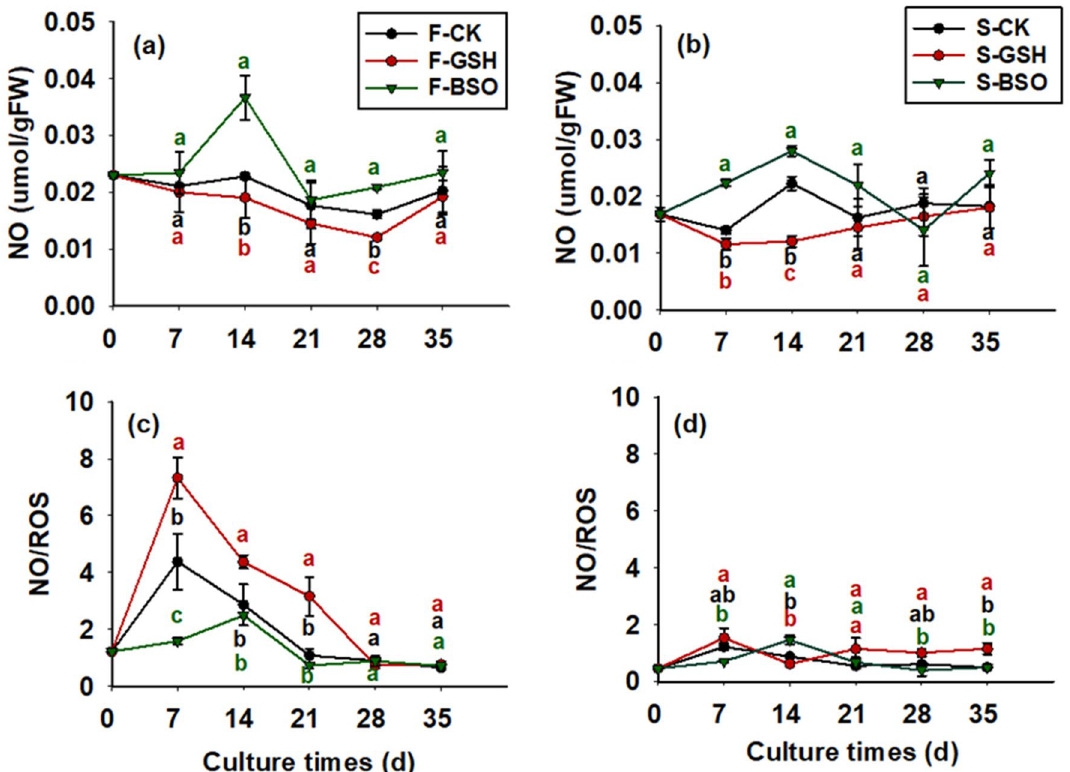
Figure 6. Effects of exogenous GSH and BSO on NO content of two Korean pine cell